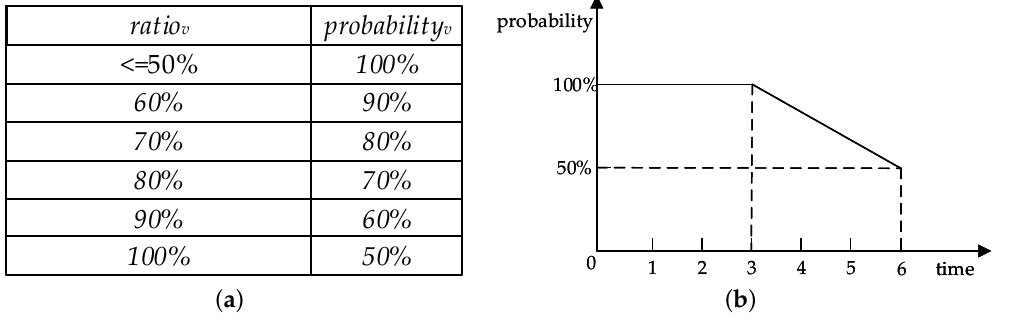
Figure 5. The statistics of actual availability time and expected availability time of the node v and membership function image of node v expected availability time which is six hours. ( a ) Statistics of actual availability time and expected availability time of the node v ; ( b ) The membership function image of the node v expected availability time which is six